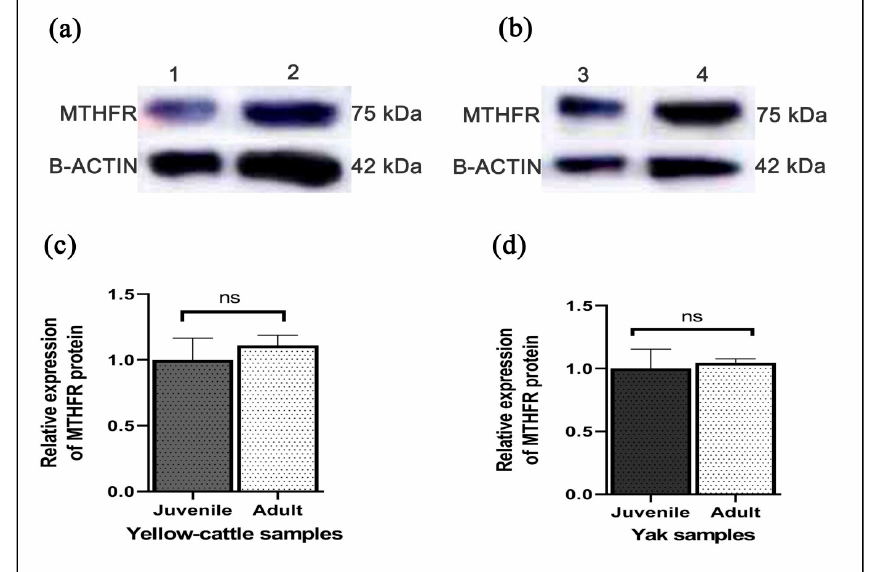
Figure 8. ( a , b ) Representative Western blot bands of MTHFR and β -Actin proteins in juvenile and adult yellow-cattle (y-c) or yak testes; juvenile (1: y-c; 3: yak), adult (2: y-c; 4: yak). ( c ) MTHFR